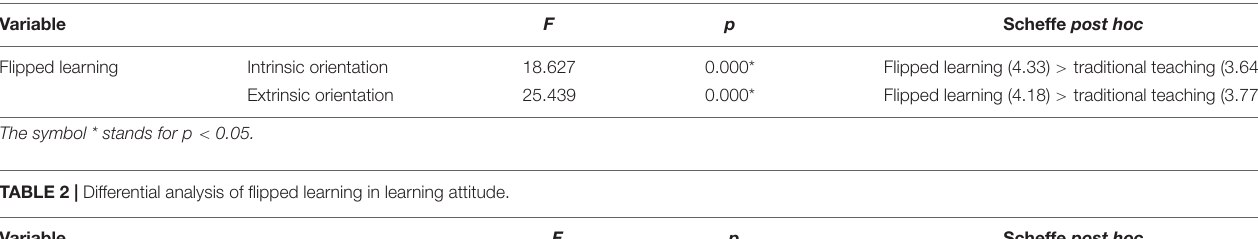
TABLE 1 | Differential analysis of flipped learning in learning motivation.